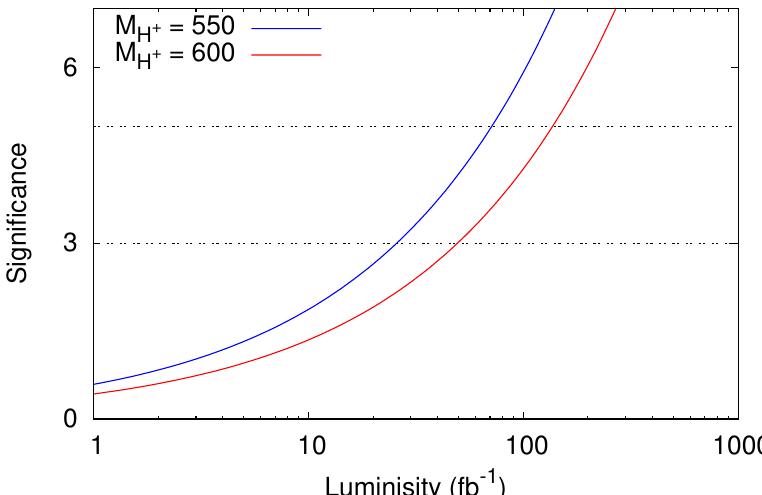
Figure 8 . Variation of statistical signi(cid:12)cance of the considered benchmark points with integrated luminosity (fb (cid:0) 1 ) for same-sign double charged